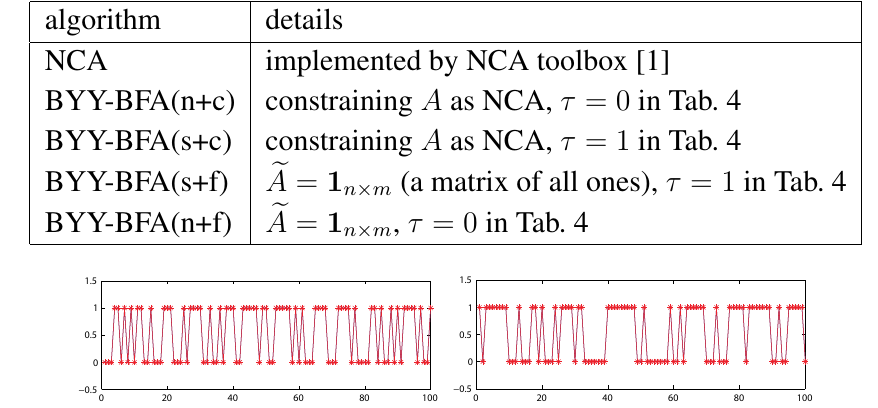
Figure 1: The true binary activities (in blue, covered by the red points) is correctly reconstructed by the ones (in red) by